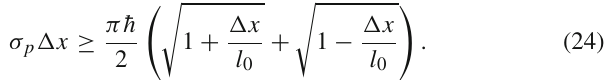
√ 2 , 0 , 0 ) √ 2. Diameters of length 2 r are also